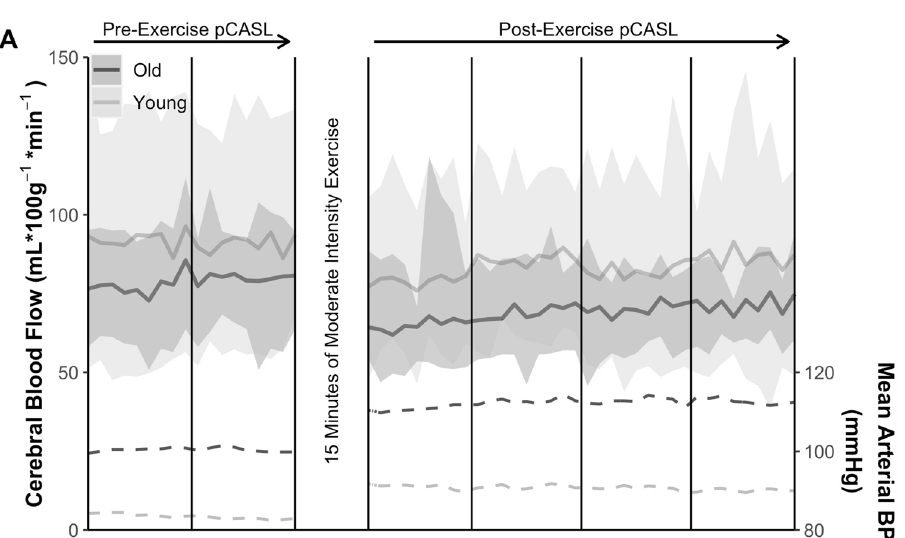
Figure 3. Preliminary proof-of-concept findings demonstrating our ability to capture gray matter cerebral blood flow (CBF) changes post-exercise. Solid lines represent the age group mean of the cerebral blood flow (CBF) signal for each labeled-control image pair with reference to the left hand ordinate. Shaded regions show the range of CBF for each age group. Dashed lines represent mean arterial pressure over the MRI timecourse. Darker lines and shading indicate the older adult cohort. Lighter lines and shading indicate the younger adult cohort. Figure created with the ggplot2 package (ver. 3.3.3) operating under open source R version 4.0.5 (2021-